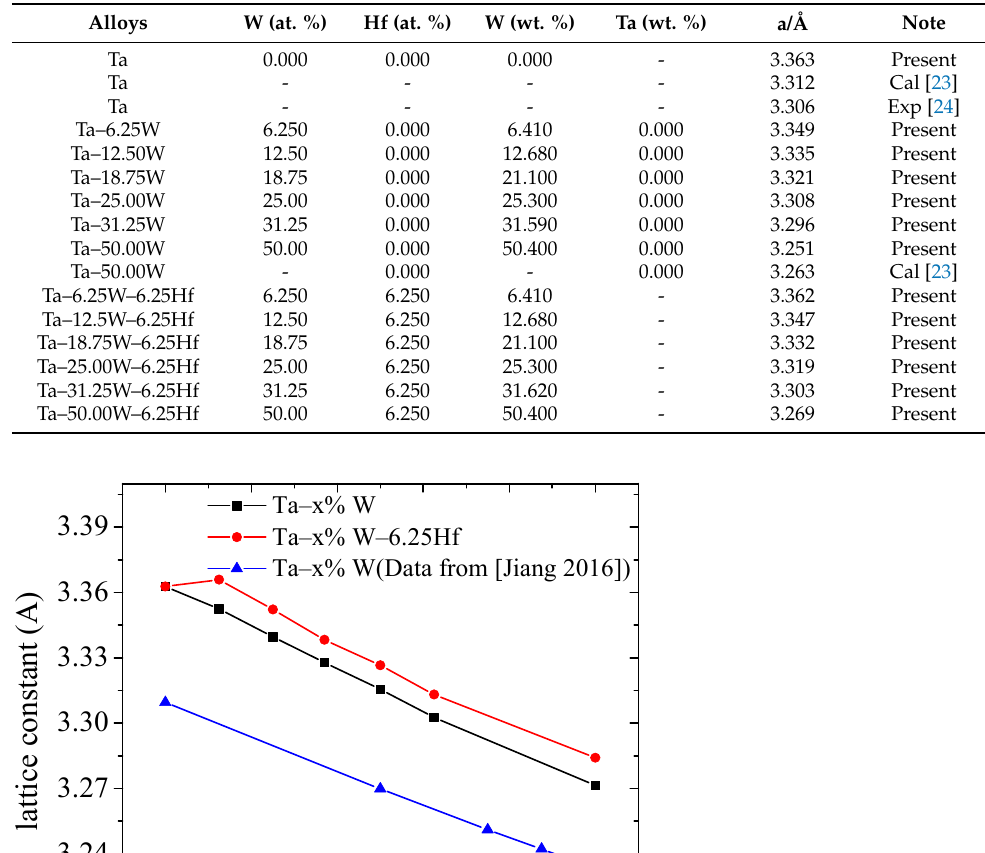
Table 2. Atom fraction and lattice constant of different density components of Ta–W–Hf alloys.